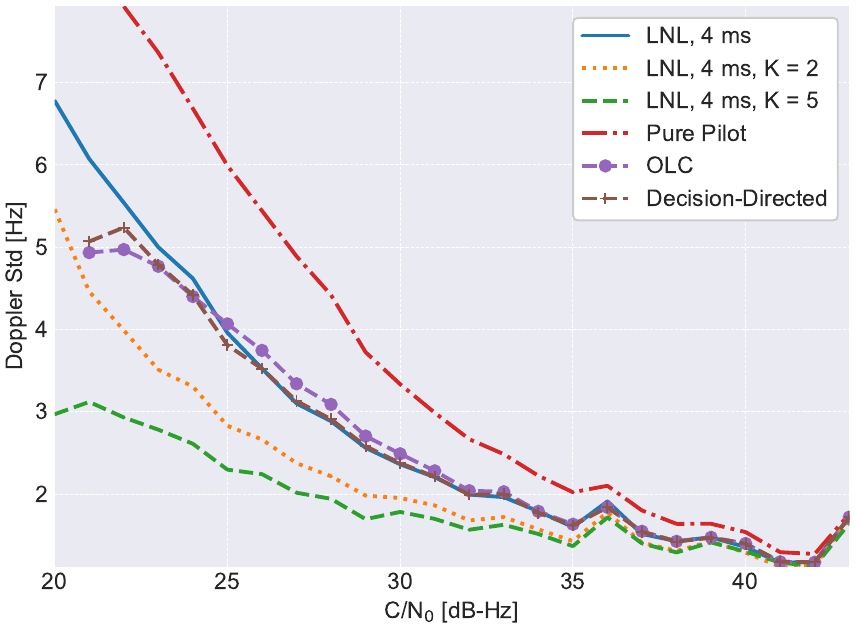
Figure 10. Standard deviation of the Doppler estimates obtained at the output of the tracking loop as a function of the C / N 0 . Different processing configurations are